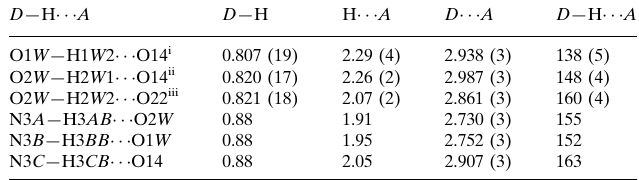
Hydrogen-bond geometry (A˚ , (cid:4)